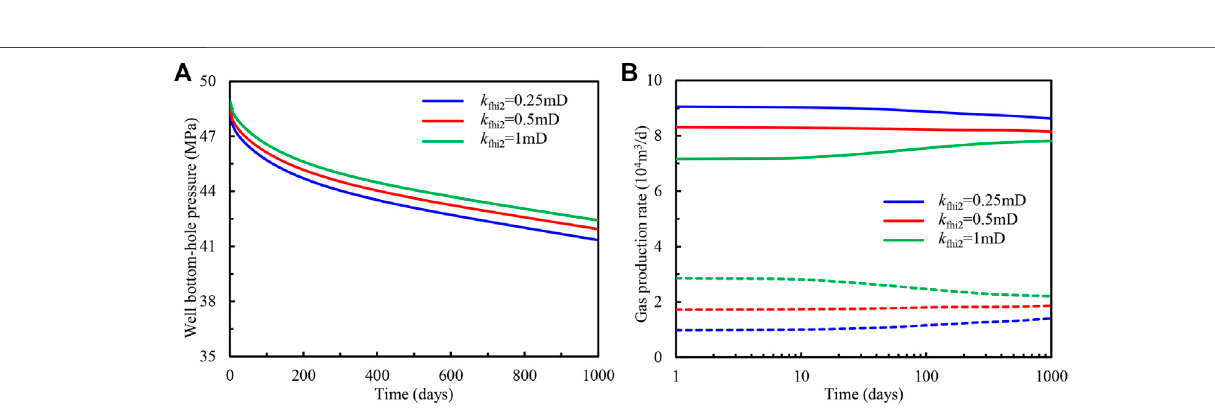
Frontiers in Energy Research |